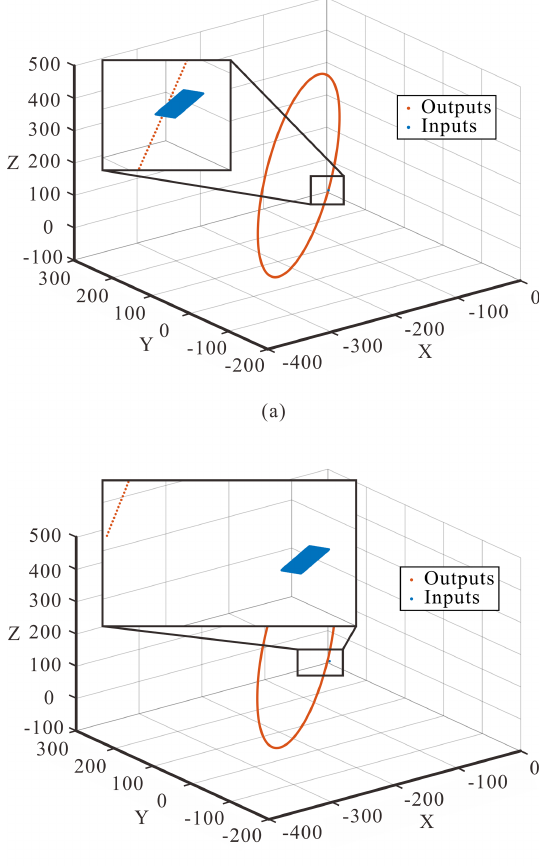
Figure 11. Relationship of the workspace between input and output parts when θ 1 = 109 ◦ . (a) θ 40 = − 107 . 975 ◦ . (b) θ 41 = − 107 . 95 ◦